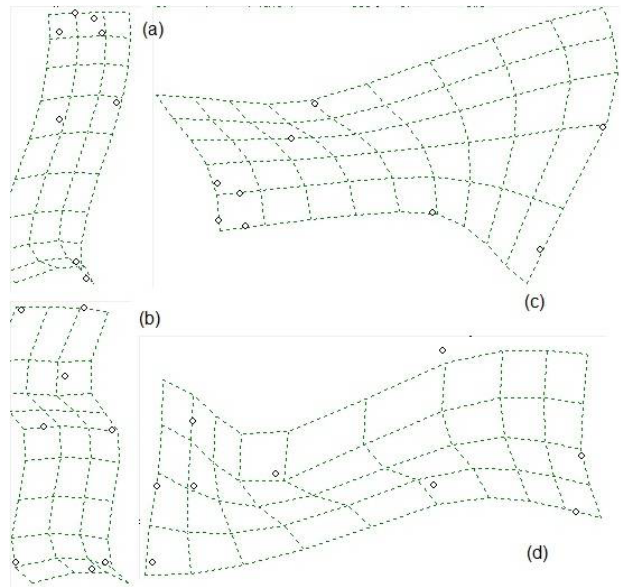
Fig 2 . Thin plate spline representation of principal trends (relative warps) in the variation of the body shape. Grid show the deformation of the average shape in opposite directions of the first relative warps for Corotoca melantho and Constrictotermes cyphergaster in top view (a and b) and in lateral view (c and d).